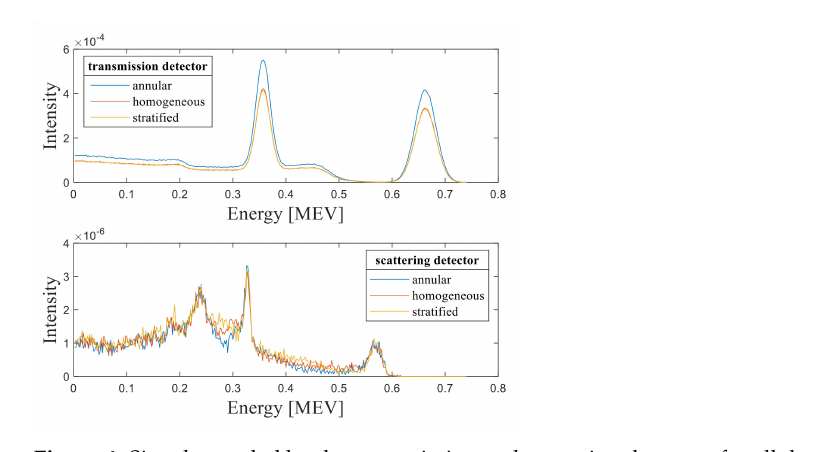
Figure 4. Signal recorded by the transmission and scattering detectors for all three simulated regimes at 2 cm scale thickness and 55% void